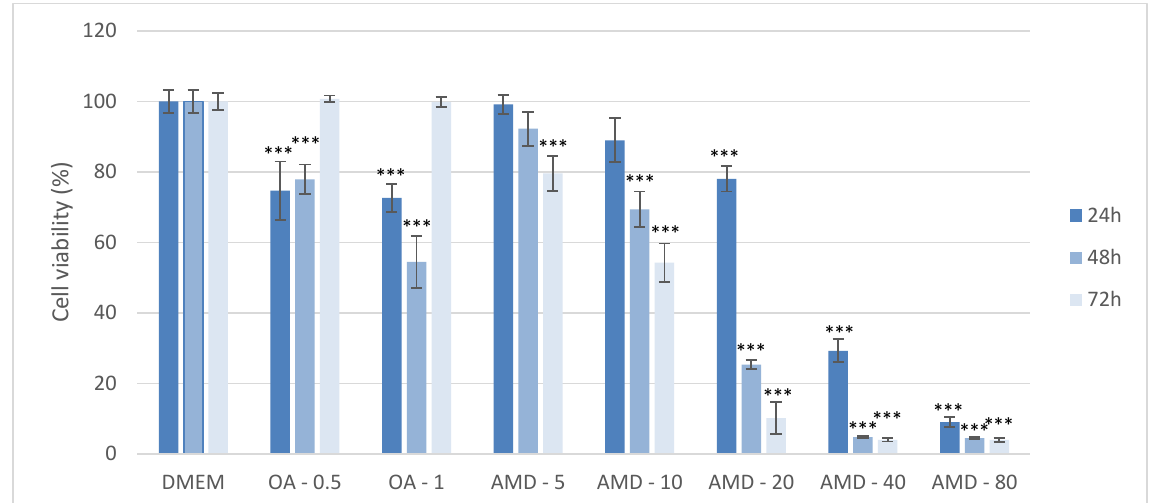
Figure 1. Determination of cell viability by MTT assay after exposure to varying amiodarone (AMD) and oleic acid (OA) concentrations and varying time periods in the Huh7 cell line. MTT measurements were done by spectrophotometry at 595 nm. Results are shown as a percentage relative to the negative control of at least three biological replicates. Two-way ANOVA Time period F (2, 71) = 88.8; p = 7.41 × 10 − 17 , Treatment F (7, 71) = 741.1; p = 1.23 × 10 − 46 ; post-hoc Tukey HSD. Bars assigned with asterisks are statistically significantly different (*** p < 0.001) compared to the negative control. Dulbecco’s modified Eagle’s medium (DMEM), oleic acid (OA/mM), amiodarone (AMD/ µ M).